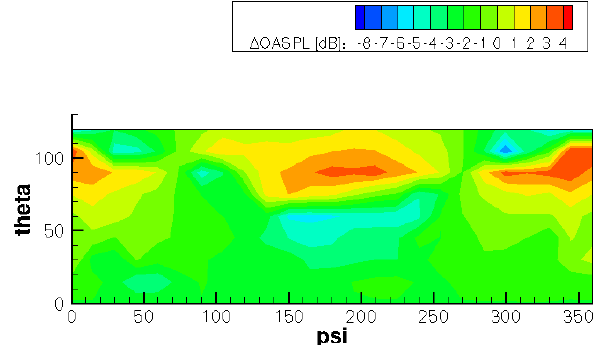
Figure 9: Technique A – B differential OASPL at point 1 in maneuver ID8021.